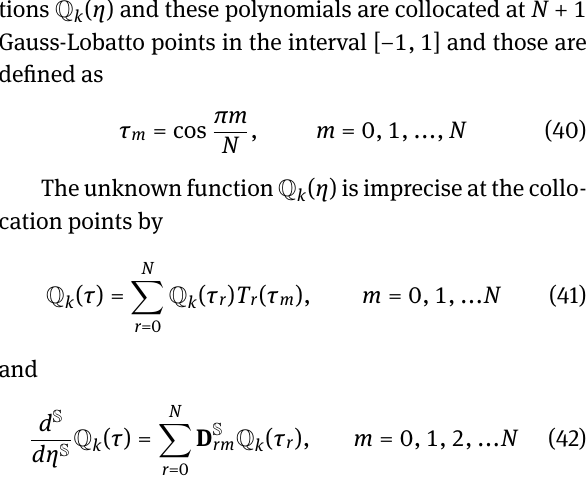
Table 2: Comparison of − θ ′ (0, 0) and − ϕ ′ (0, 0) for different values of B and Le when Gr * = 0 , α 1 = 0 , α 2 = 0 , n = 1 , λ = 1 , Bi → ∞ , and Ω = 0